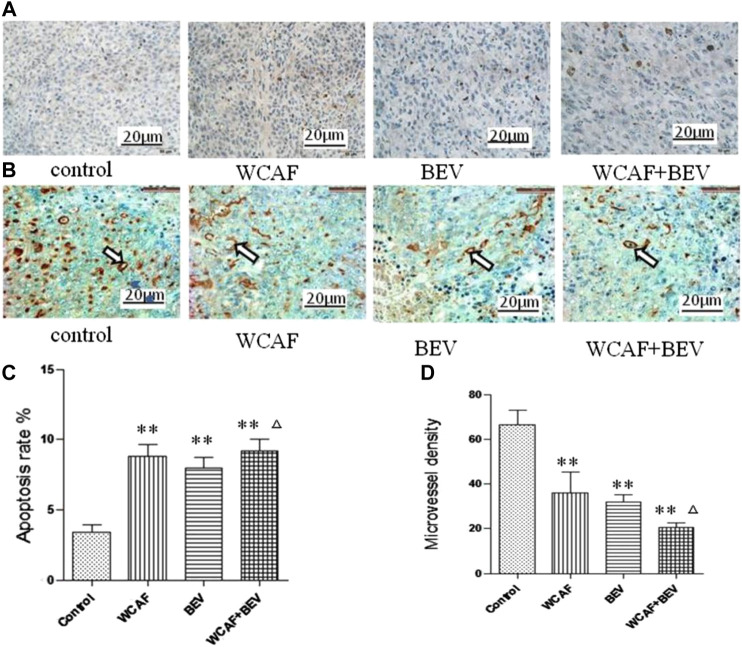
Effect of WCAF on apoptosis and angiogenesis in colon carcinoma. (A,C) Tumor apoptosis was assessed by TUNEL assay (×400), **
p < 0.01 vs. control group. △
P< 0.05 vs BEV group (B,D) Expression of CD31 protein in four subcutaneous xenografts in nude mice (immunohistochemical staining, ×400), **
p < 0.01 vs. control group. △
P< 0.05 vs BEV group.